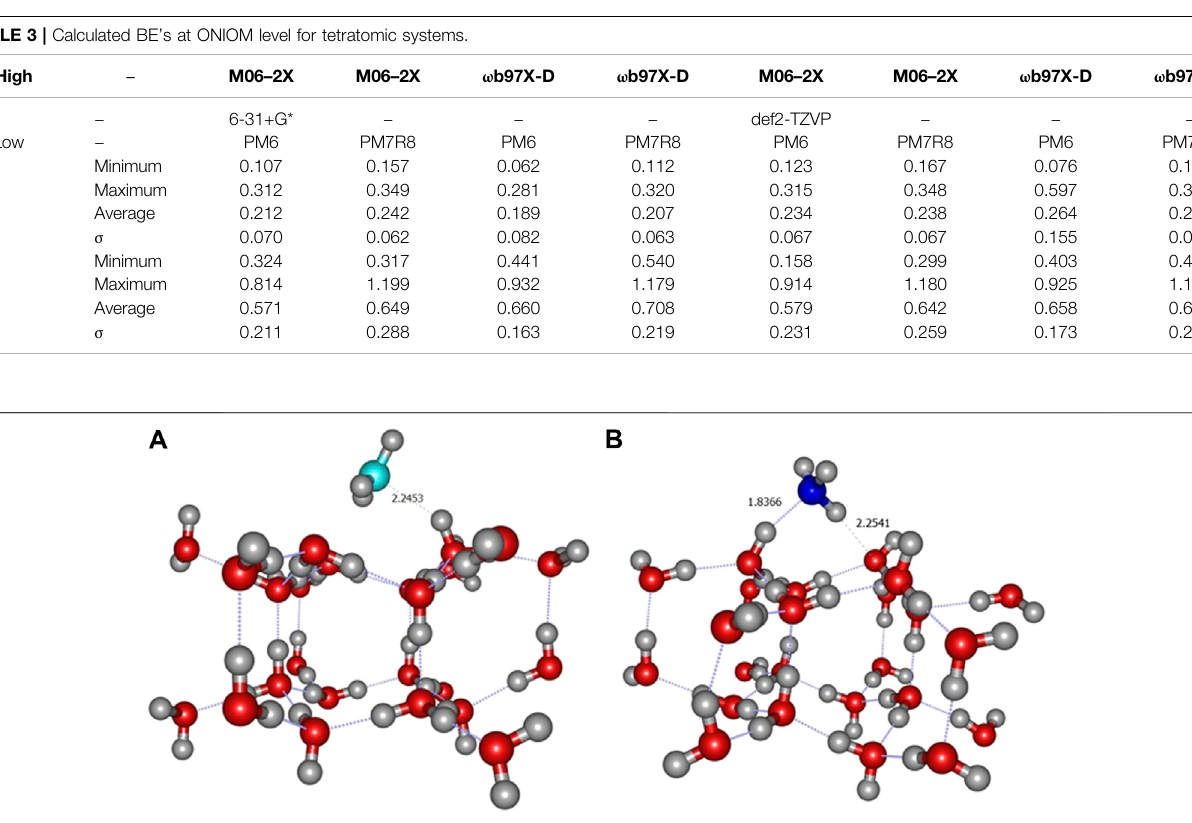
Frontiers in Astronomy and Space Sciences |